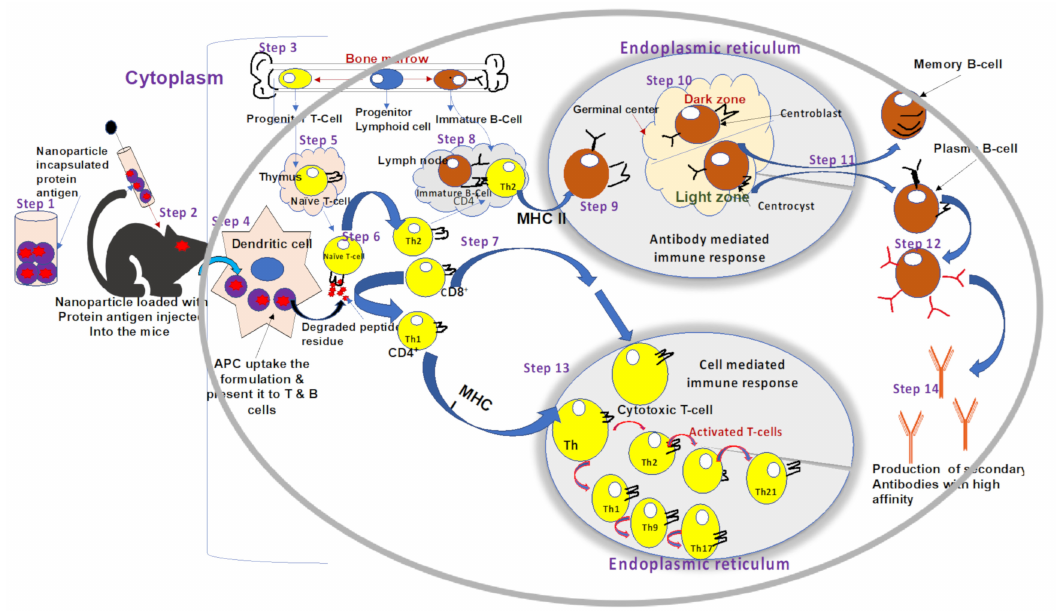
Figure 5. Viral proteins incorporated with nanoparticles of different sizes delivered by immune cells to stimulate T cells and humoral immunity [148–152]. The smaller (10–200 nm) nanoparticle-based vaccines are readily released into the bloodstream and flow on to the lymph nodes for further activation of Th1 and Th2. On the other hand, larger nanoparticles, approximately over 200 nm in size, are first processed by dendritic cells (DCs) and then the antigens can enter the lymph nodes for further presentation and possible activation of immune cells by the small peptide residues released by DCs [153,154]. The small peptide residues bind to the major histocompatibility molecules (MHC) of class I or II, to activate both cellular and humoral immunity responses to foreign